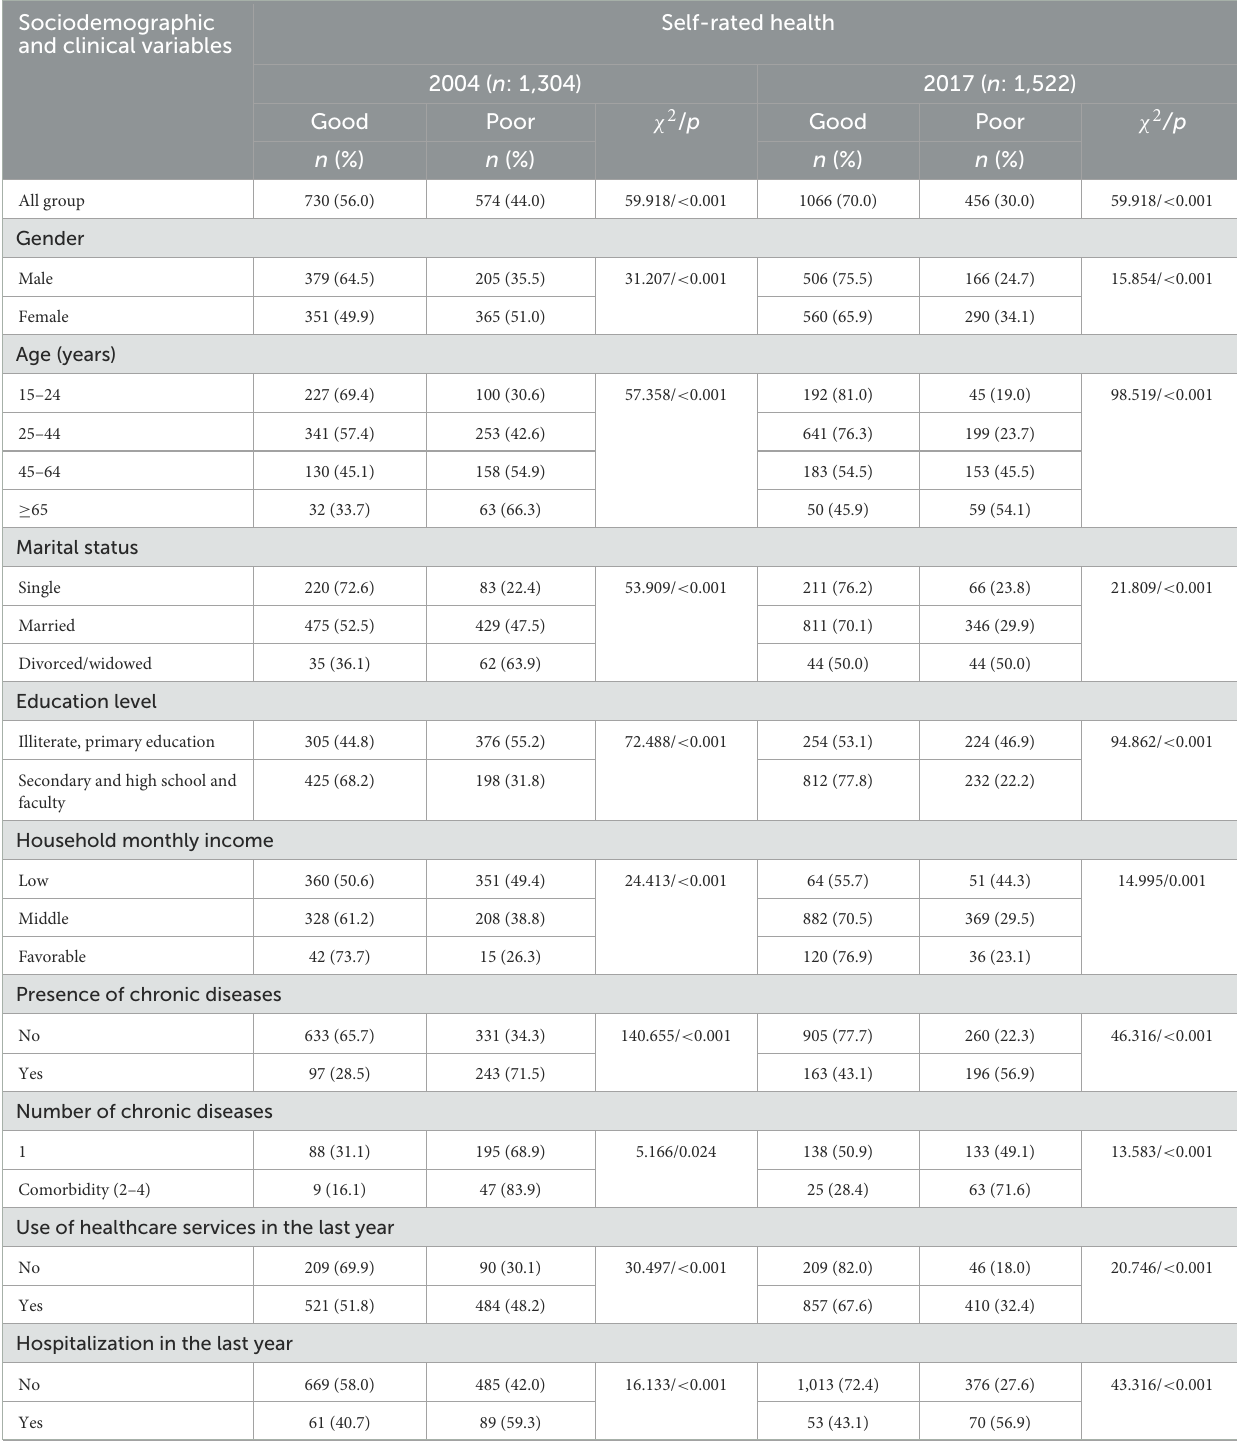
TABLE 2 Patient-reported sociodemographics and clinical outcomes in people aged 15 years and over by their self-rated health (SRH) at baseline. Sociodemographic and clinical